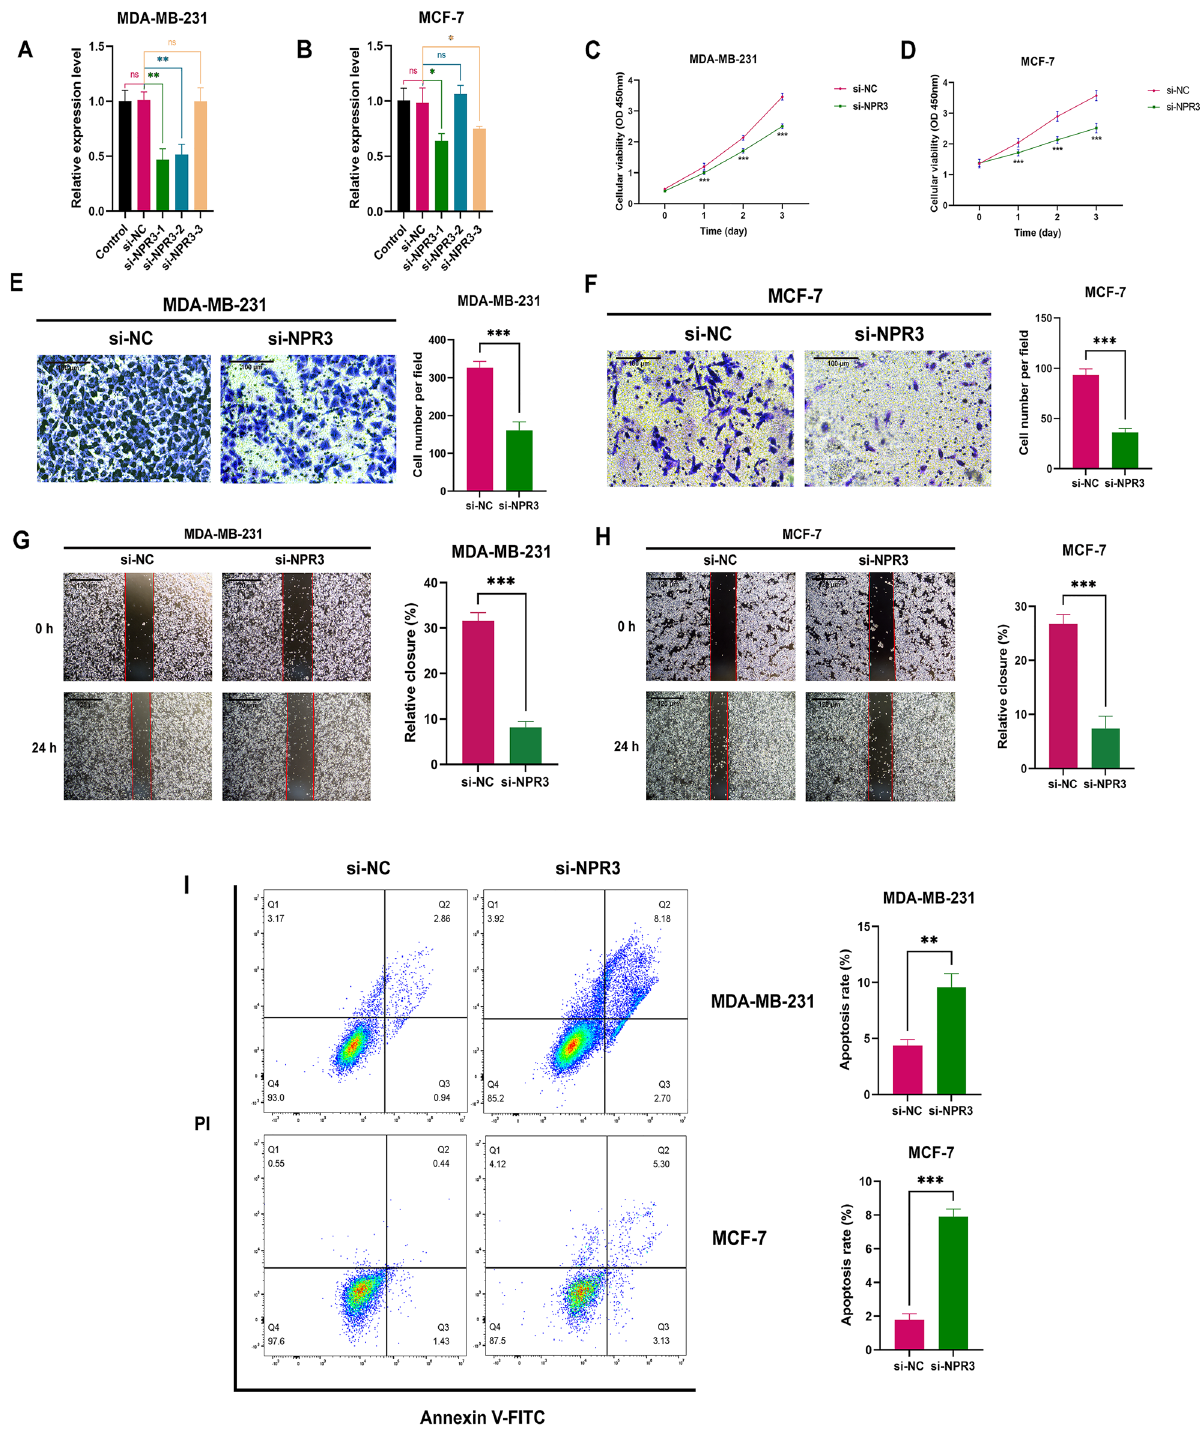
Figure 12. The effect of NPR3 on the proliferation, migration, and apoptosis of breast cancer (BC) cells. The results of quantitative reverse transcription polymerase chain reaction (qRT ‒ PCR) showed that si-NPR3-1 successfully knocked down the expression of NPR3 in MDA-MB-231 ( A ) and MCF-7 ( B ) cells (n = 3). * indicated P < 0.05, ** indicated P < 0.01, ns indicated no significance, P value based on t-test. The depletion of NPR3 observably suppressed the proliferation ability in both MDA-MB-231 ( C ) and MCF-7 ( D ) cells compared with the si-NC group (n = 3). *** indicated P < 0.001, P value based on t-test. The knockdown of NPR3 significantly decreased the migration of MDA-MB-231 ( E , G ) and MCF-7 ( F , H ) cells (n = 3). ** indicated P < 0.01, *** indicated P < 0.001, P value based on t-test. ( I ) Flow cytometry indicated that NPR3 deletion could increase apoptosis in MDA-MB-231 and MCF-7 cells (n = 3). ** indicated P < 0.01, *** indicated P < 0.001, P value based on t-test. All experiments were implemented separately in triplicate. BC breast cancer, qRT ‒ PCR quantitative reverse transcription polymerase chain